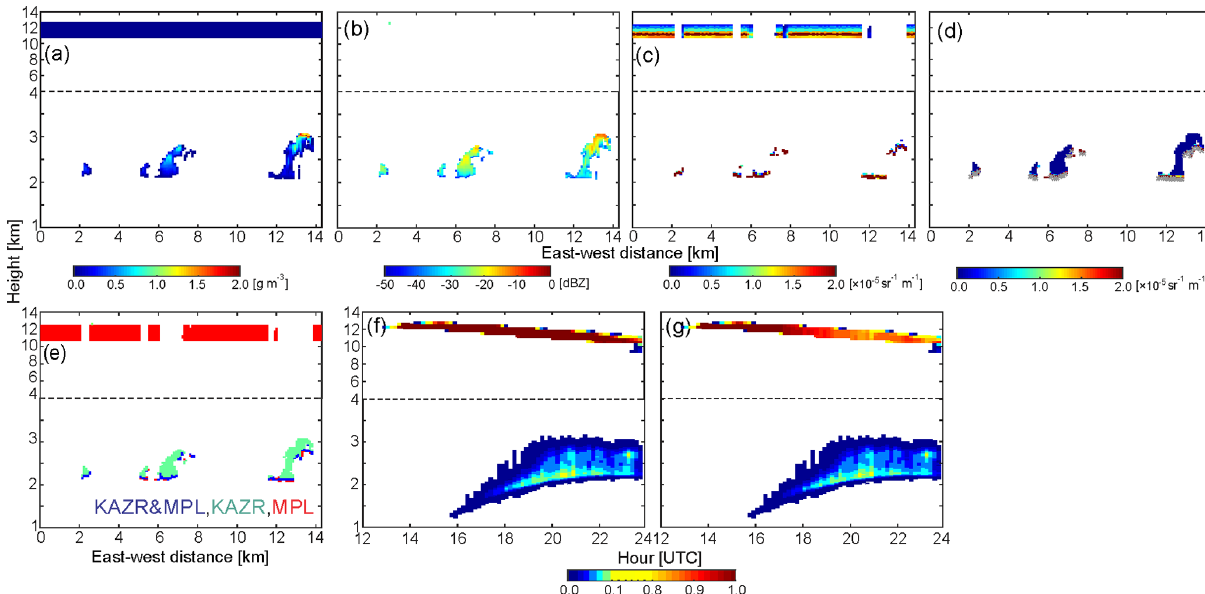
Figure 6. Simulated vertically pointing radar and lidar measurements and the ARSCL product for a shallow convection case on 27 June 2015. (a–e) Vertical cross sections of (a) water content from the WRF model, (b) Ka-band (35GHz) radar reflectivity accounting for radar sensitivity and attenuation, (c) MPL attenuated backscatter, (d) ceilometer backscatter (color bar) and first cloud base (gray dots), and (e) the ARSCL cloud mask. (f, g) Height versus time cross sections of domain-averaged cloud fraction from (f) WRF water content > 0 . 001gm − 3 and (g) the simulated ARSCL product.